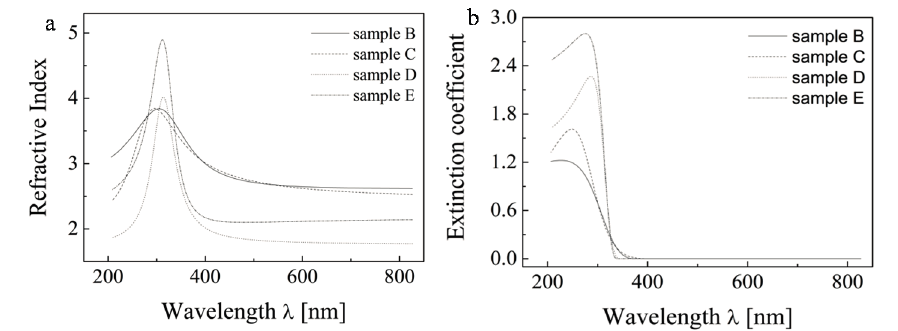
Figure 10. The dispersion dependence of the printed samples for various thickness ratios of the two sublayers of the refractive index ( a ) and extinction coefficient ( b ). Once the thickness ratio 90/10 was selected, this ellipsometric model was applied to all studied samples. These results are depicted in Figure 11 and Table 4.